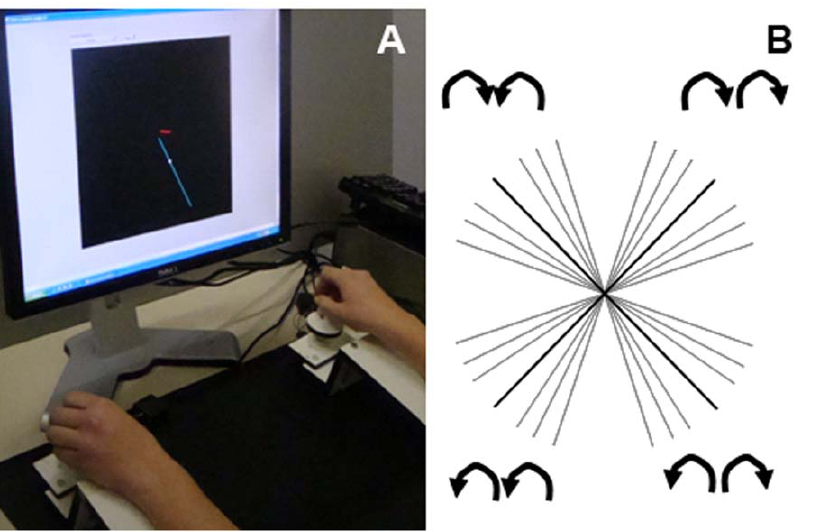
Figure 1. A. A schematic of 28 possible lines representing different bimanual coordination patterns. When lines occur closer to the vertical (y) axis, the left hand is rotating faster. When lines occur closer to the horizontal (x) axis, the right hand is leading. A bold line that is a 45 u angle indicates that the left and right hands are rotating at an equal rate (isofrequency). B. View of the experimental apparatus (please note that the hands are normally covered to prevent their vision).